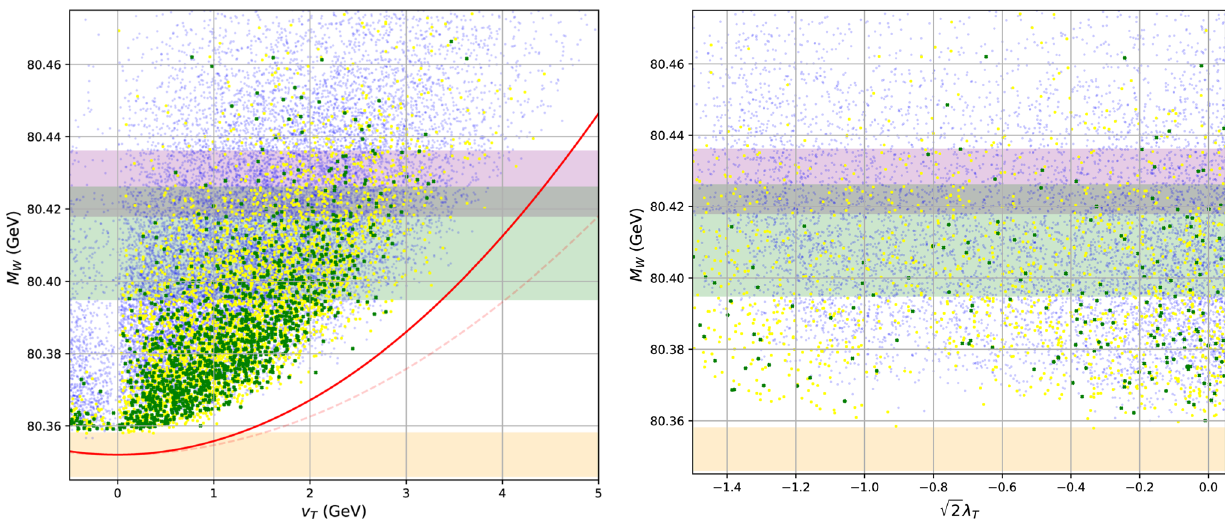
Fig. 2 Left: W boson mass vs v T in the MDGSSM, with the red curve showing the tree-level prediction. Right: W boson mass vs the MDGSSM. Colours of the points are described in the text, with